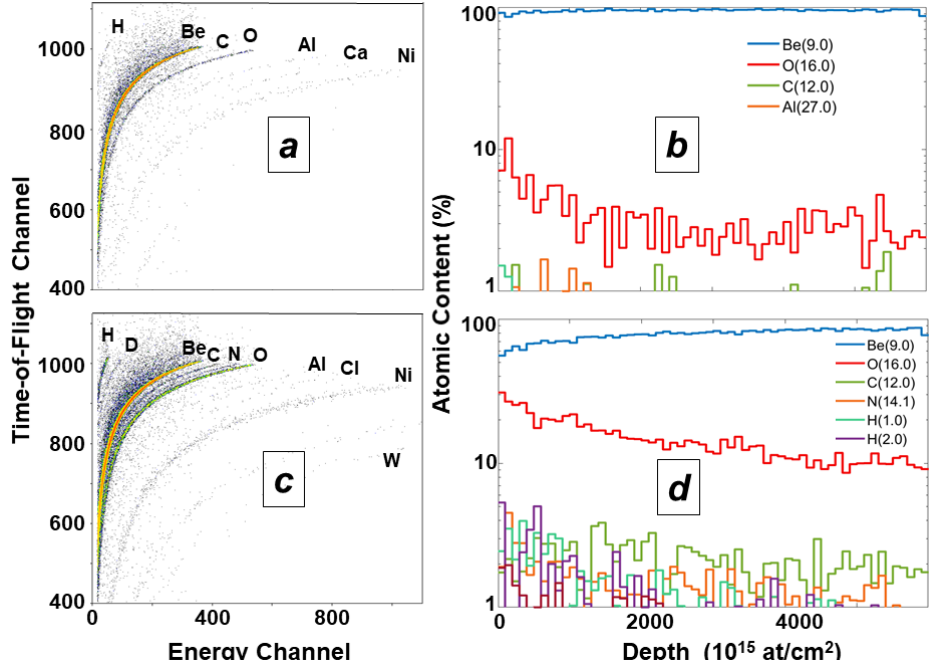
Figure 6. ToF-HIERDA spectra ( a,c ) and depth profiles ( b,d ) of species in the surface region of Be coatings from the inner wall cladding of JET-ILW for initial not exposed surfaces ( a , b ) and after exposure ( c , d ) during the first and second ILW campaign.